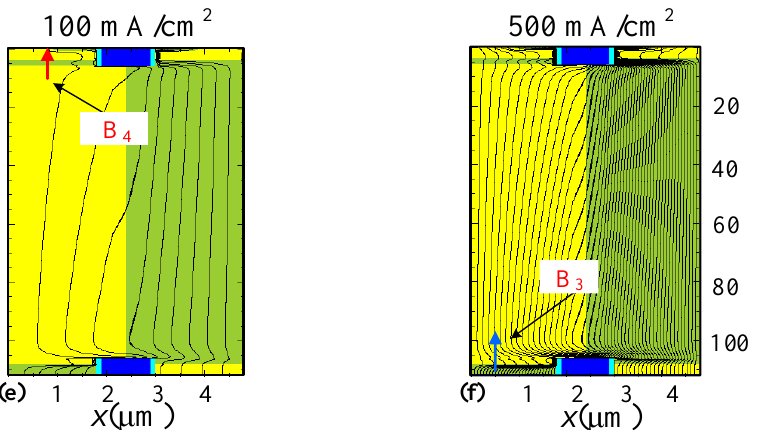
Figure 4. The forward conduction and equivalent circuit of SJ-RC-IGBT. ( a ) Forward-conducting mechanism. ( b ) Equivalent circuit at forward conduction. Forward-conducting current distribution of SJ-RC-IGBT at ( c ) 10 mA/cm 2 , ( d ) 50 mA/cm 2 , ( e ) 100 mA/cm 2 , and ( f ) 500 mA/cm 2 . The bias condition of forward conduction is that the gate and collector are positively biased, and the emitter is grounded. All the contours of current density are 4.8 × 10 −10 A/µm. Blue arrows represent electron injection and red arrows represent hole injection.